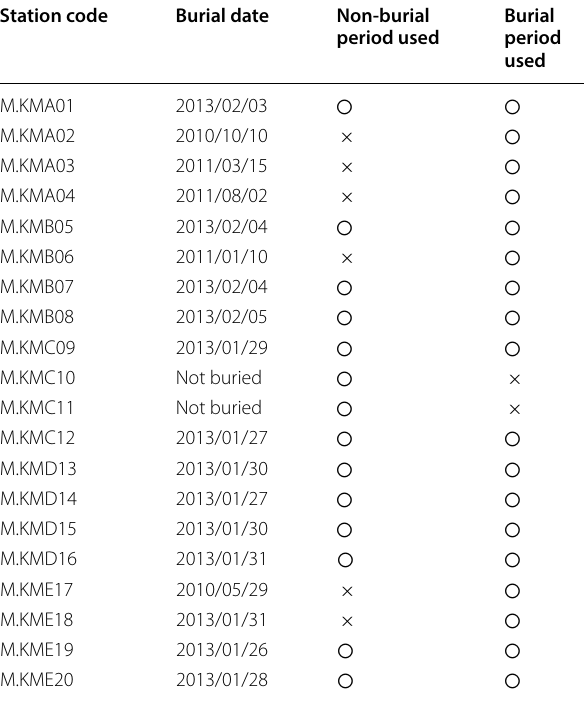
Table 1 Burial information for the studied DONET1 stations